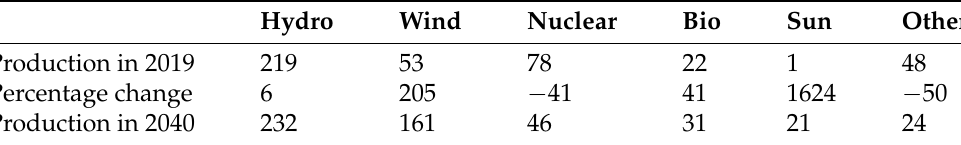
Table 13. Total electricity production in the Nordic countries in the year 2019 and expected pro- duction in the year 2040. Figures in TWh. Figures from The Norwegian Water Resources and Energy Directorate.